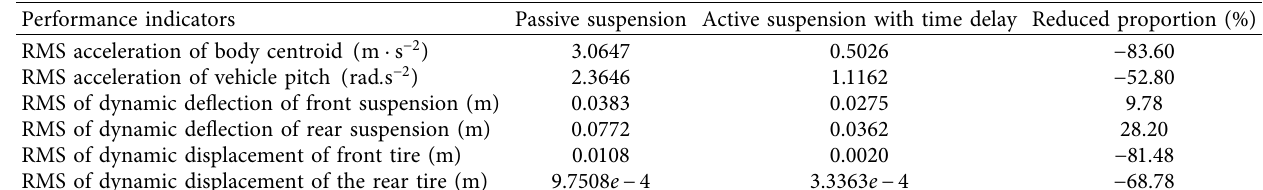
Figure 5: Simulation comparison of ride comfort index under harmonic excitation. (a) Body acceleration. (b) Body pitch acceleration. (c) Dynamic deflection of the front suspension. (d) Dynamic deflection of the rear suspension. (e) Front suspension tire displacement. (f) Rear suspension tire Table 2: RMS value of ride comfort index under harmonic excitation.